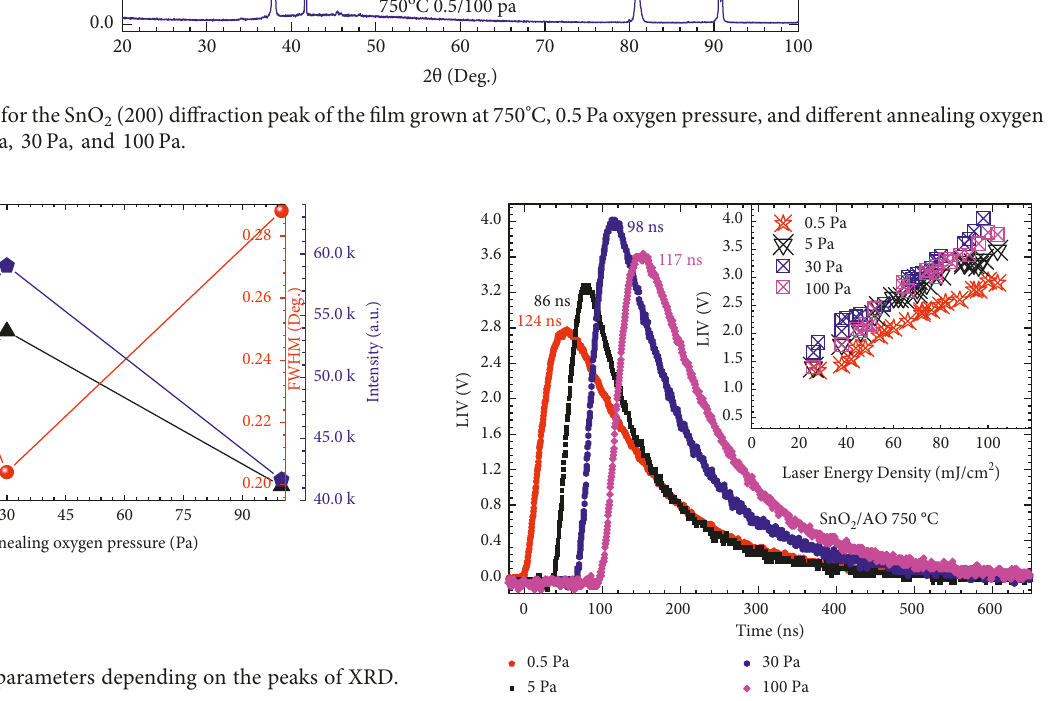
Figure 4: LIV signals of SnO 2 /Al 2 O 3 thin films as a function of annealing oxygen pressure; the inset is the linear relation between the peak values of the laser incident energy